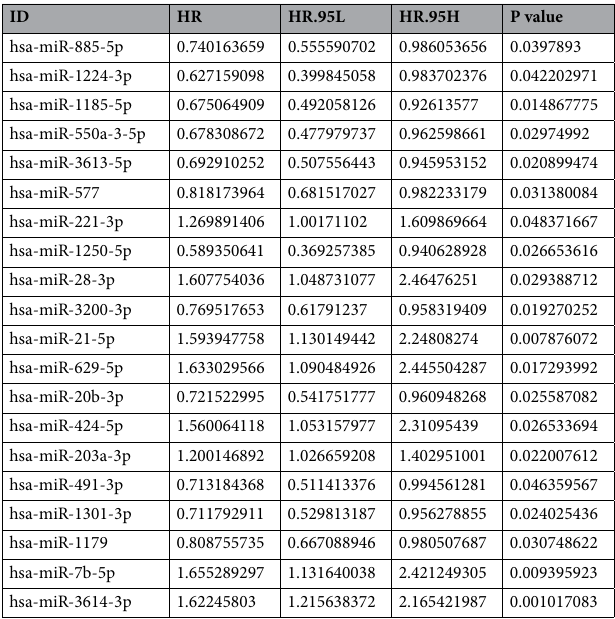
Table 1. Results of univariate Cox regression analysis of prognostic